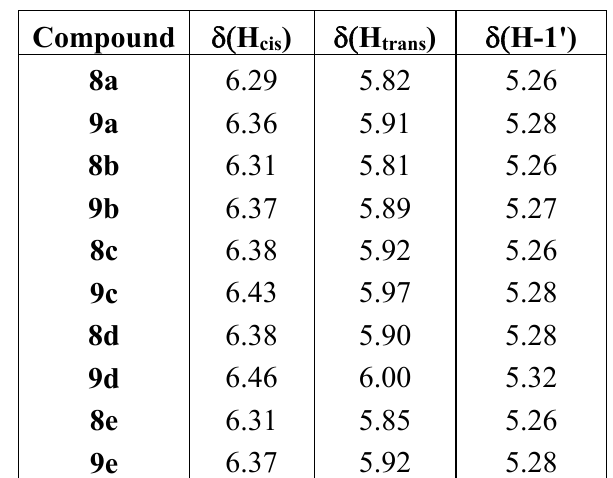
Table 1. Significant 1 H-NMR data for both olefinic protons and H-1' in compounds 8 and